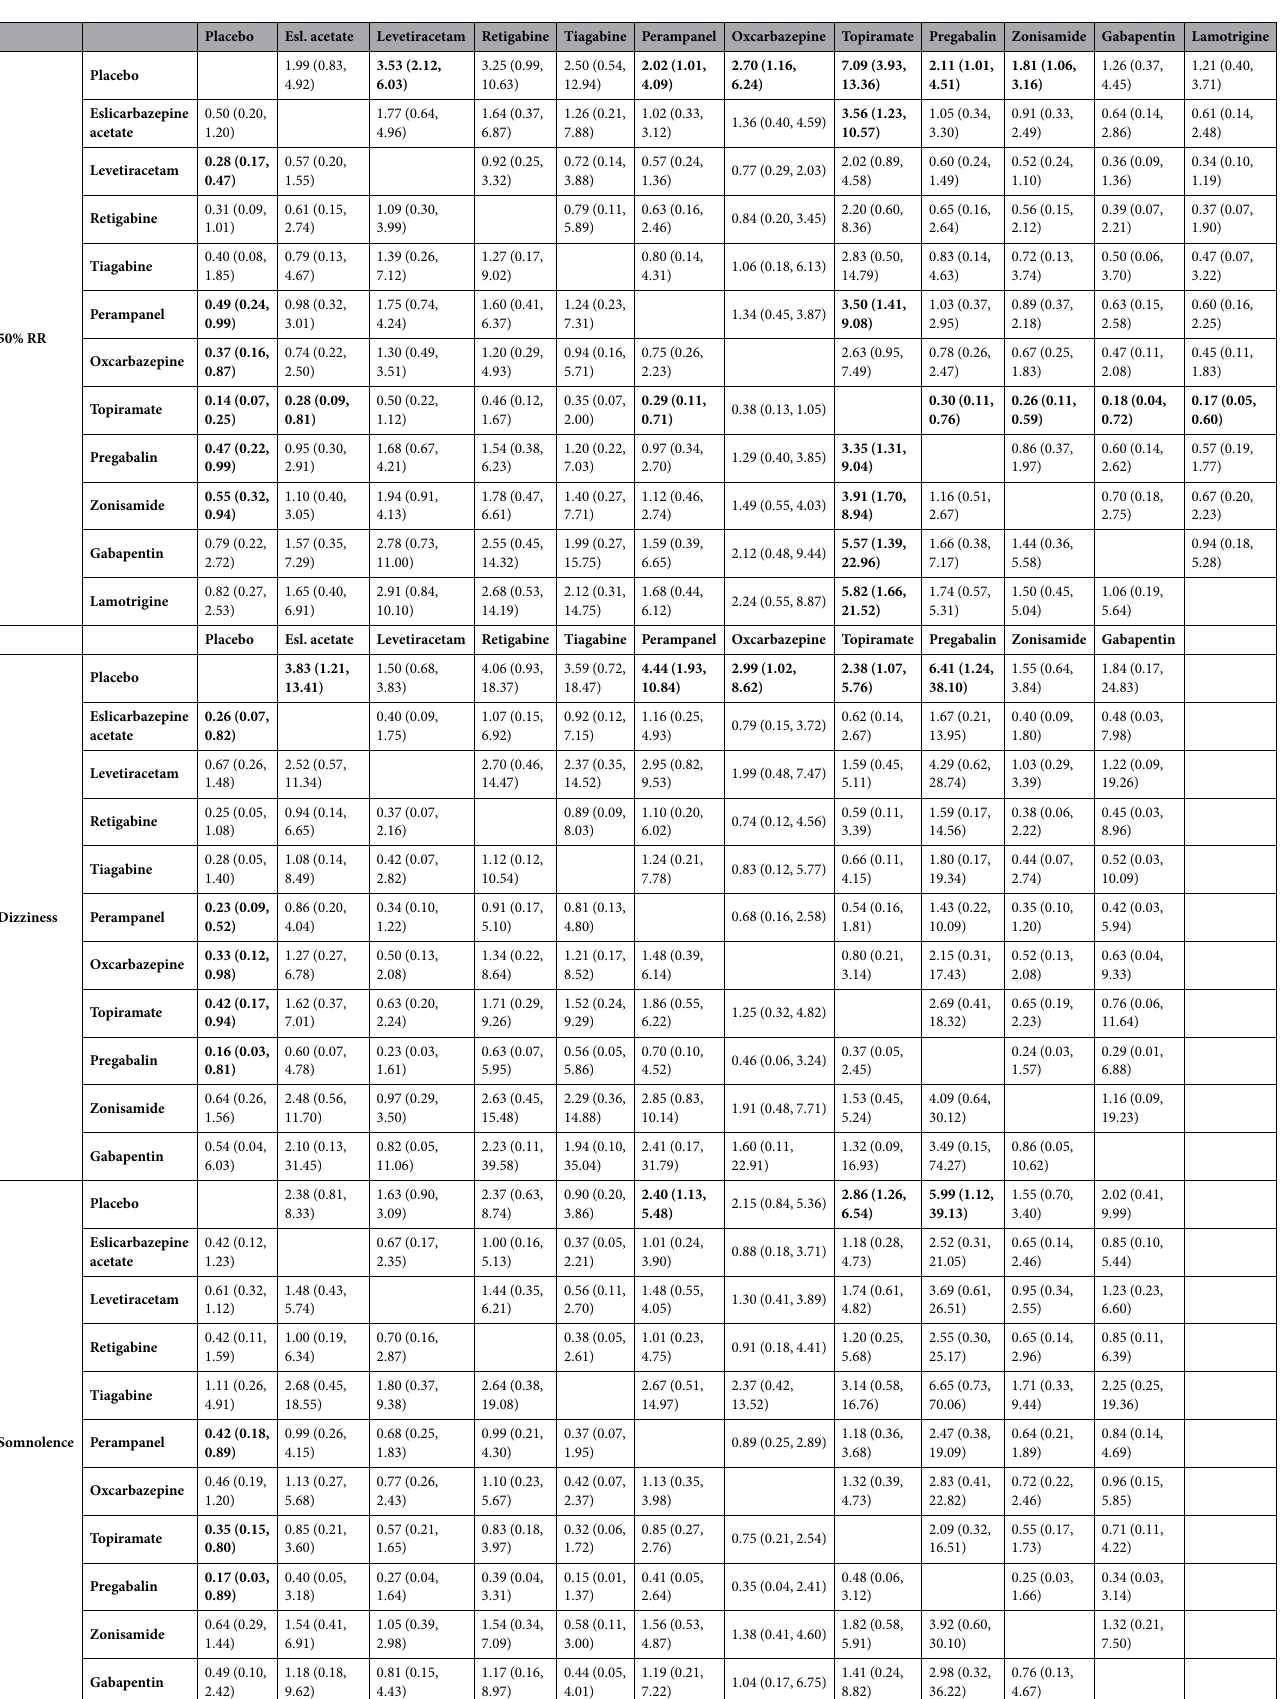
Table 2. NMA analysis results for 50% responder rate, dizziness and